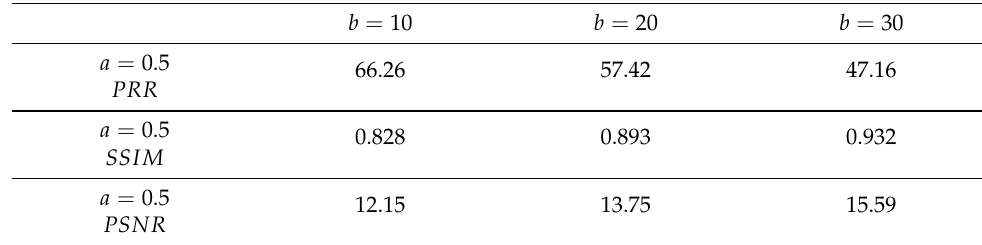
Figure 4. PSNR and MSE of the Y CBCS (without HE) and Y new ( Y CBCS with HE) for Lena image. Table 2. Lena image without HE for a = 0.5.